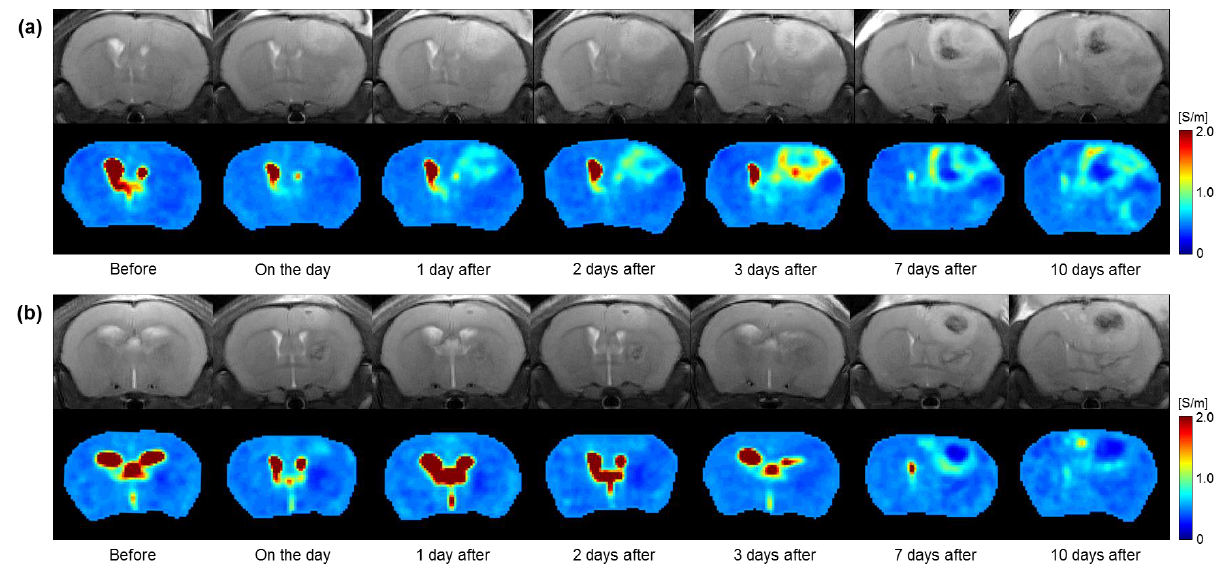
Figure 3. Time-course variations in MR (upper) and electrical conductivity (lower) images of in vivo mouse brains in the group with ( a ) and without ( b ) irradiation.